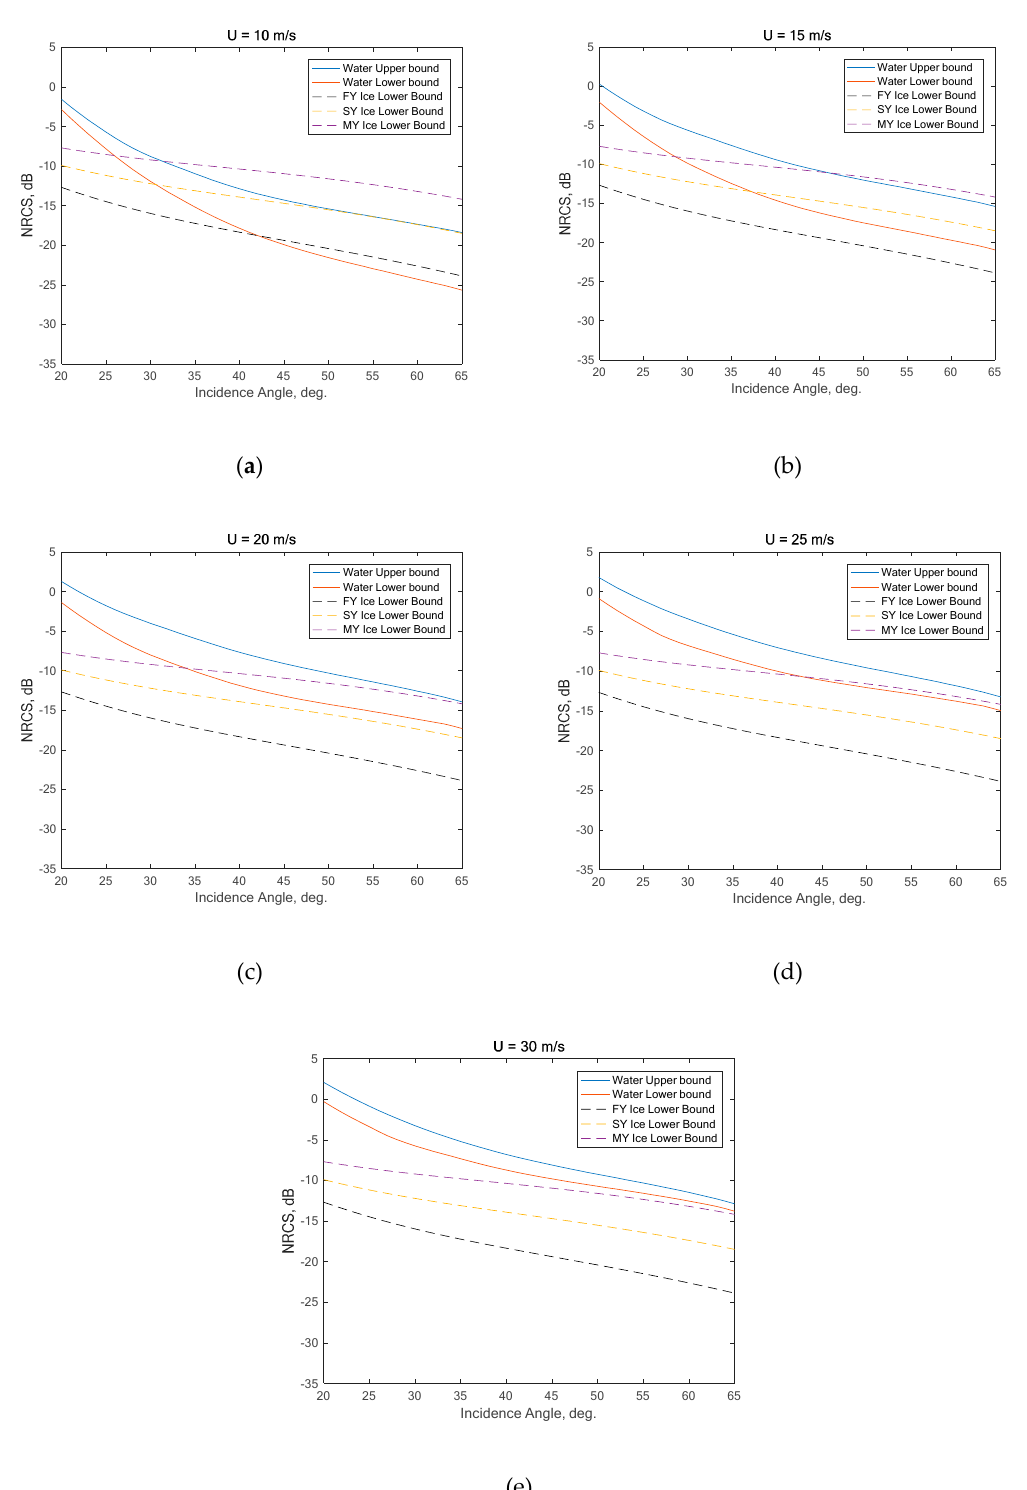
Figure 4. Positional relationship of the sea ice lower boundaries for FY, SY, and MY ice at the NH and the water NRCS upper and lower boundaries at high wind speeds depending on the incidence angle from 20° to 65°: ( a ) wind speed of 10 m/s; ( b ) wind speed of 15 m/s; ( c ) wind speed of 20 m/s; ( d ) wind speed of 25 m/s; and ( e ) wind speed of 30 m/s.